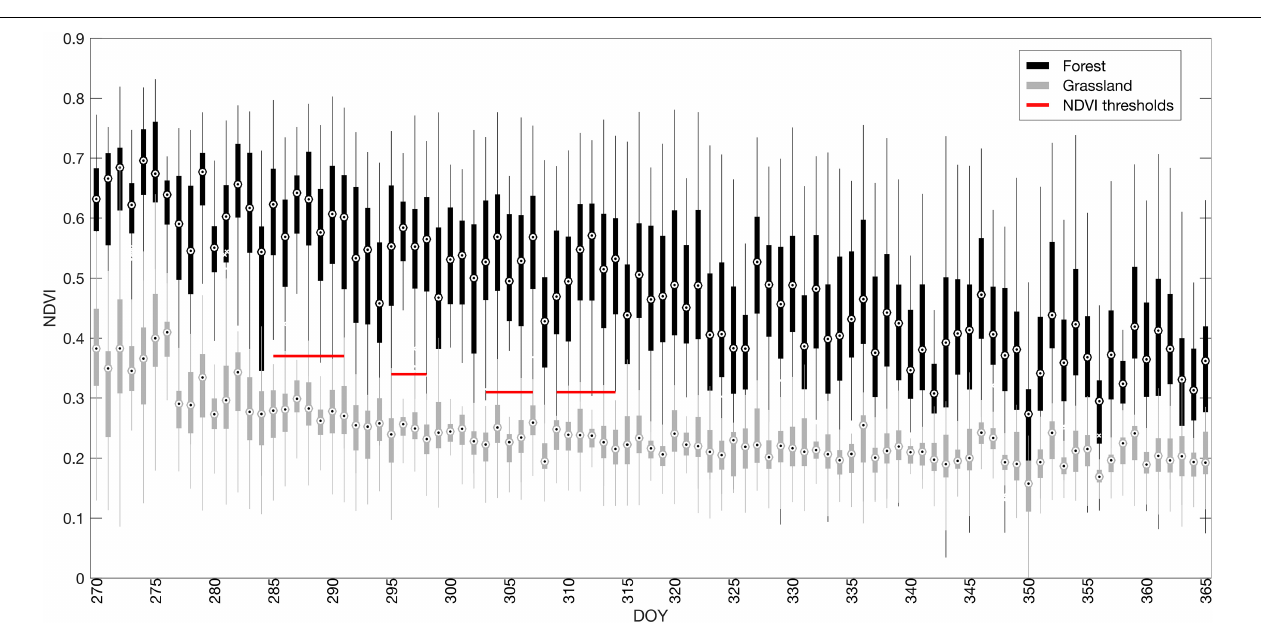
FIGURE 4 | Boxplots of NDVI values for calibration pixels for forest (black) and grassland (gray). The boxplots are based on NDVI data from Landsat 5, 7, and 8 for years 1987–2017. The red lines depict the NDVI threshold values for four periods.